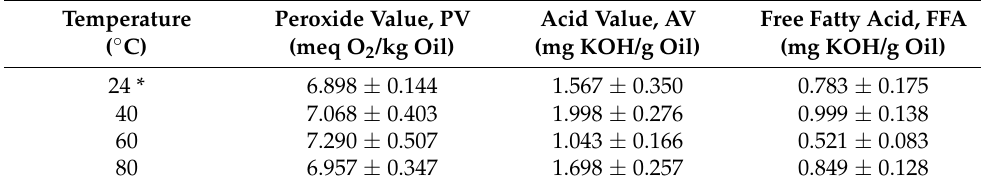
Table 6. Mean and standard deviation of the chemical properties of the extracted oil samples.